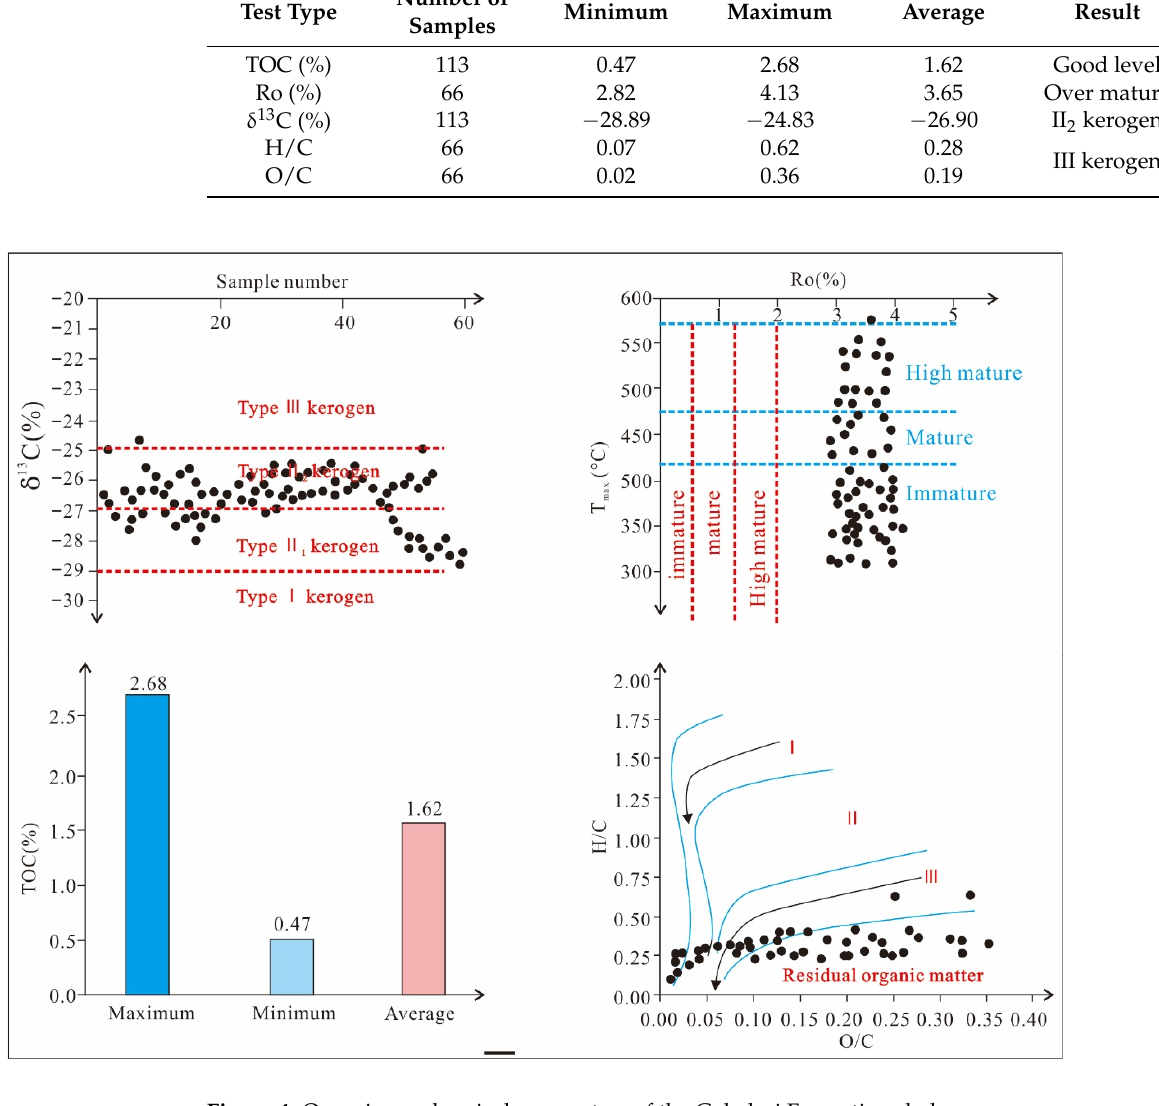
Table 2. The field analysis data of the Galedesi Formation shale in the Tianye 1 Well. Sample Number Well Depth (m) TOC (%) Total Hydrocarbon (%) Gas Content (m 3 /t) 1